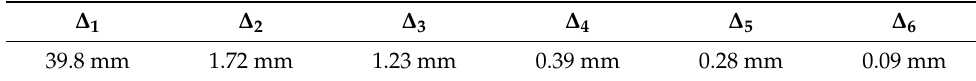
Table 1. CFR elongation of each winding segment. ∆